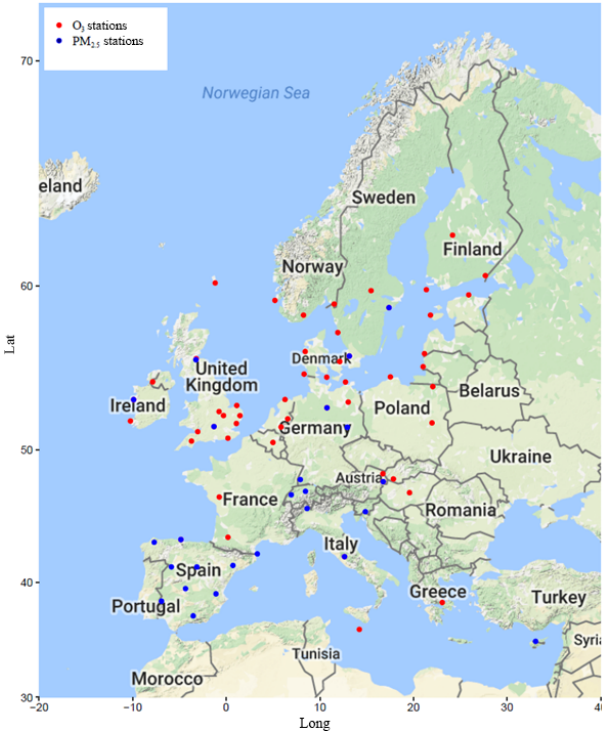
Figure 1. EMEP measurement stations with altitude less than or equal to 200m, used for seasonal mean surface O 3 comparison to modelled concentrations (52 sites are red) and EMEP measurement stations used for seasonal mean PM 2 . 5 comparison to modelled con- centrations (25 sites are